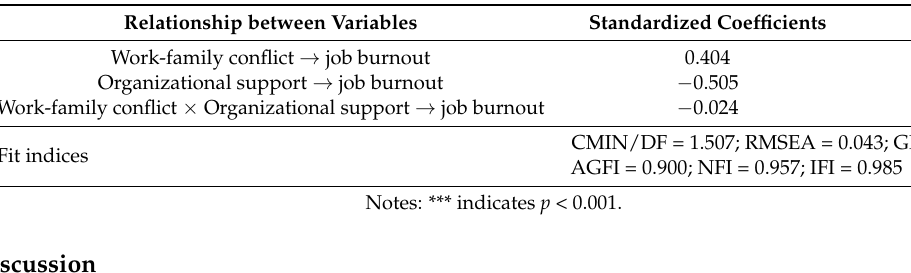
Table 7. The results of moderating effect